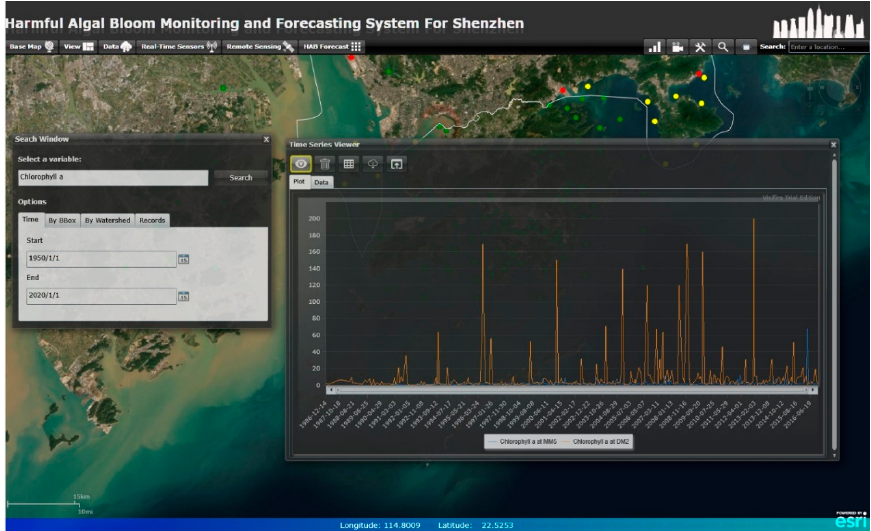
Figure 5. Example of point observational time series search and visualizations: time series of chlorophyll-a measured at two stations named MM5 and DM2.